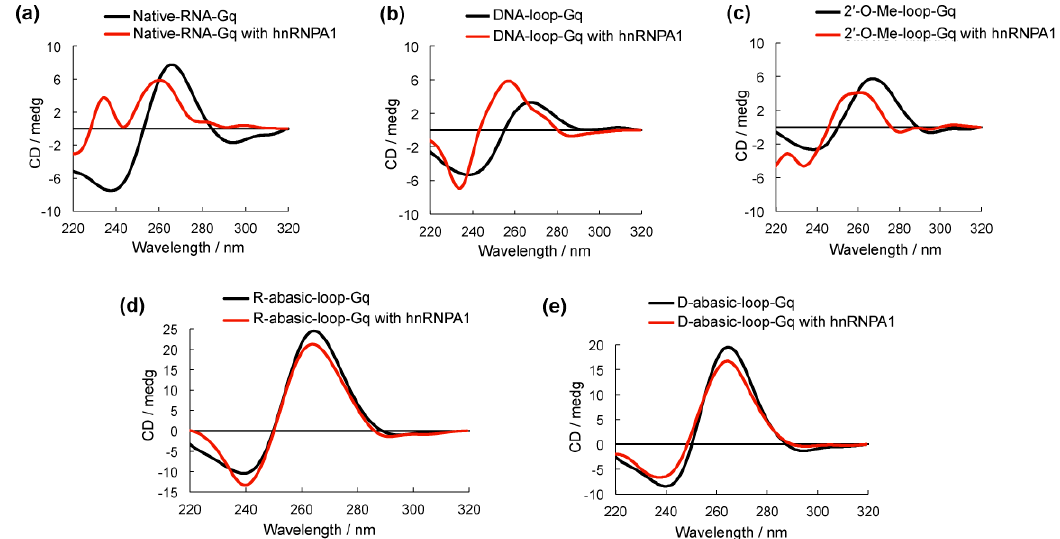
Figure 3. Circular dichroism (CD) spectra of G-quadruplexes with (red line) and without (black line) heterogeneous nuclear ribonucleoprotein A1 (hnRNPA1) in 100 mM NaCl and 10 mM Tris-HCl buffer (pH 7.0). The 5 µM hnRNPA1 was added to 5 µM oligonucleotides and incubated for 1 h at room temperature before spectra were obtained at 20 °C.